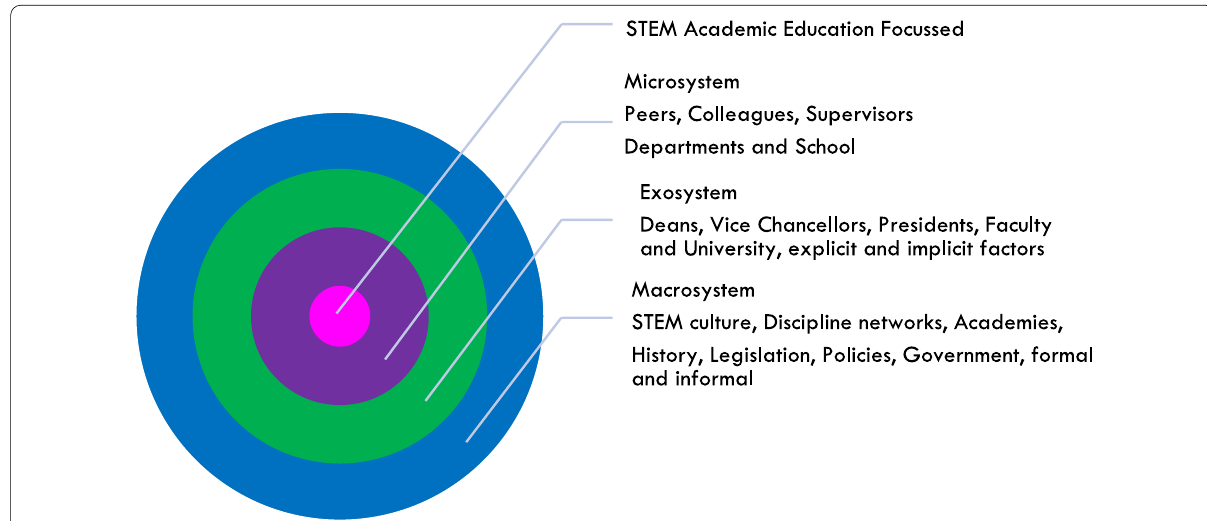
Fig. 1 Bronfenbrenner’s socio-ecological model representing the layers of influence on STEM academics focussed on education in higher